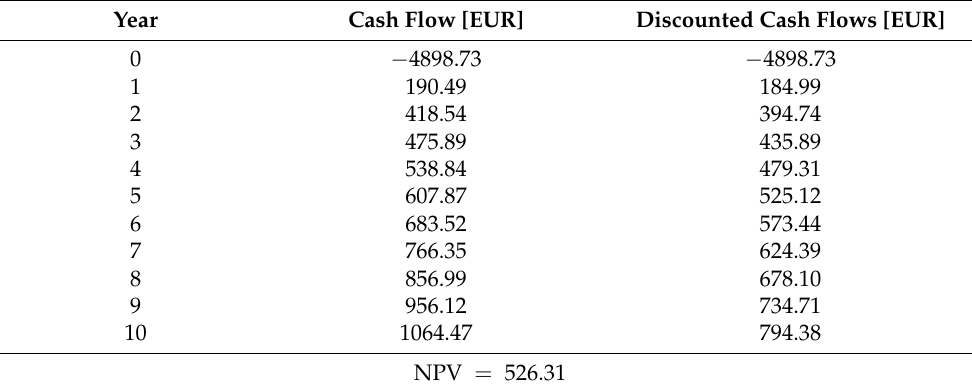
Table 5. Cash flows discounted with the assumed rate of return of 2.97%.